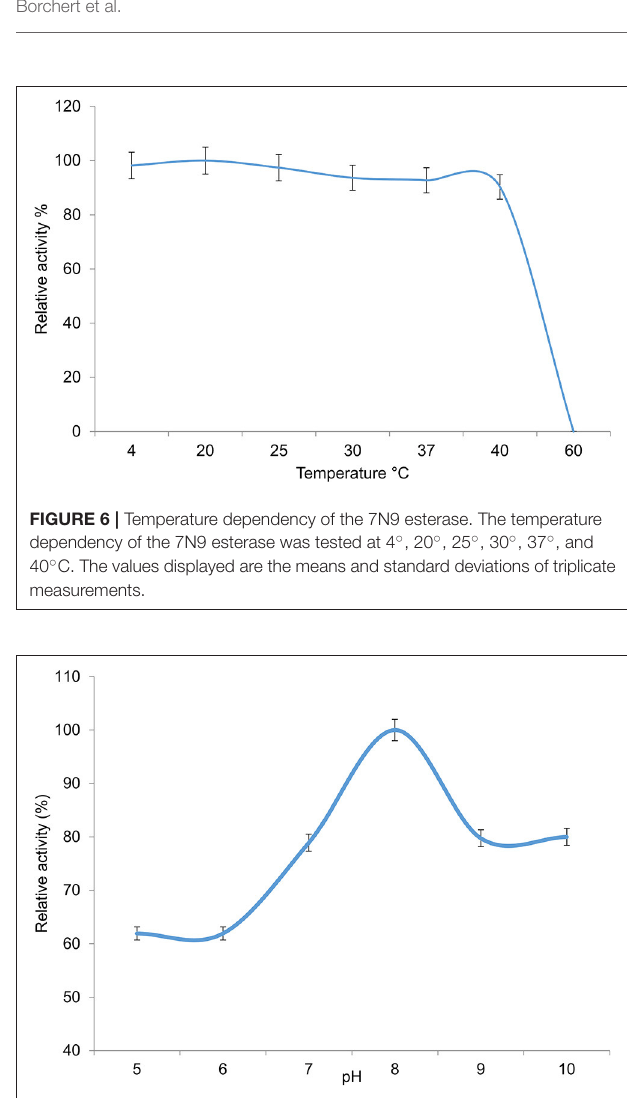
FIGURE 7 | pH dependency of 7N9 esterase. The pH dependency of the 7N9 esterase was assessed at pH 5, pH 6, pH 7, pH 8, pH 9, and pH 10. The values displayed are the means and standard deviations of triplicate